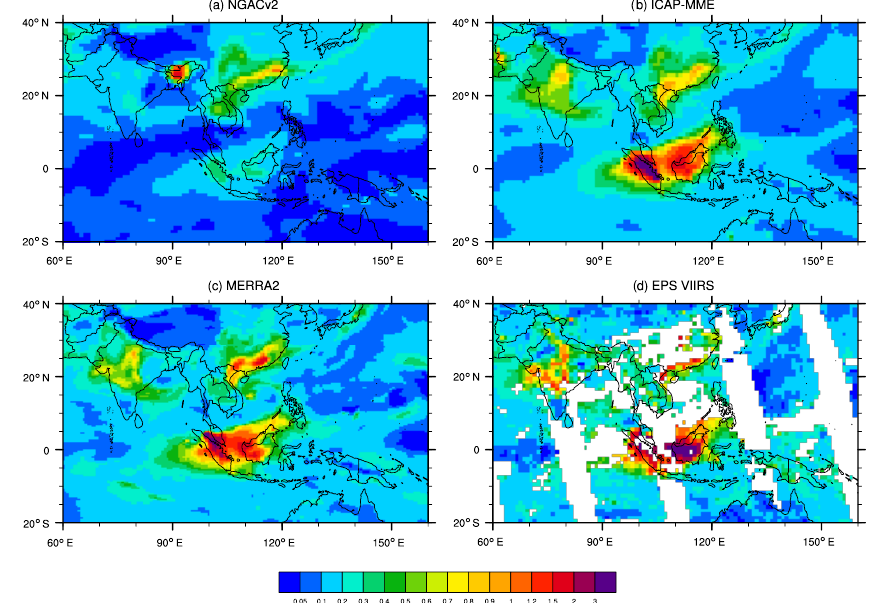
Figure 13. Total AOT at 550nm on 13 September 2015 from NGACv2, ICAP-MME, MERRA-2 and EPS-VIIRS. Satellite observation has data gaps, which are white in panel (d) . MERRA-2 data resolution is at 0 . 5 ◦ × 0 . 625 ◦ . The rest of them are at a 1 ◦